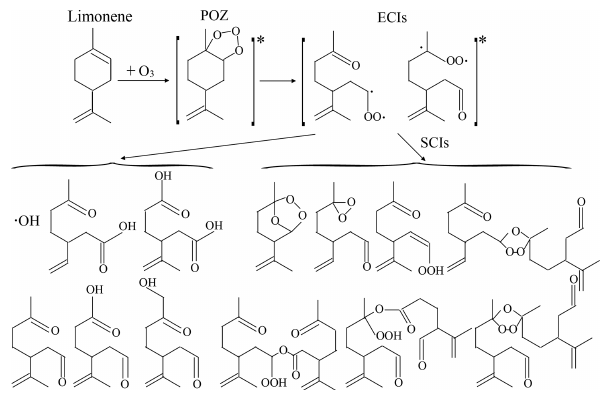
Figure 7. Reaction scheme of limonene